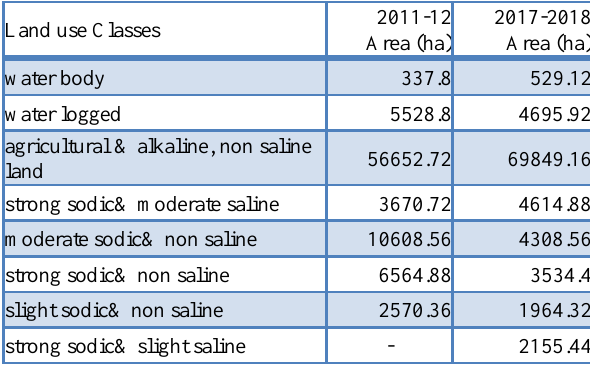
Table 4: Landuse classes by Unsupervised